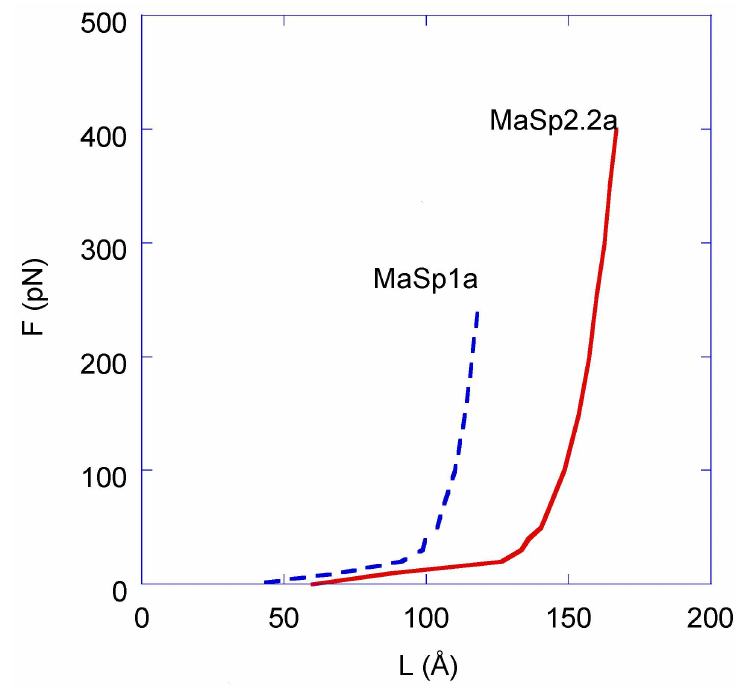
Figure 3. Force–distance curves obtained from the MD calculations on A. aurantia MaSp1a and MaSp2.2a fragments (values may be found in Supplementary Table